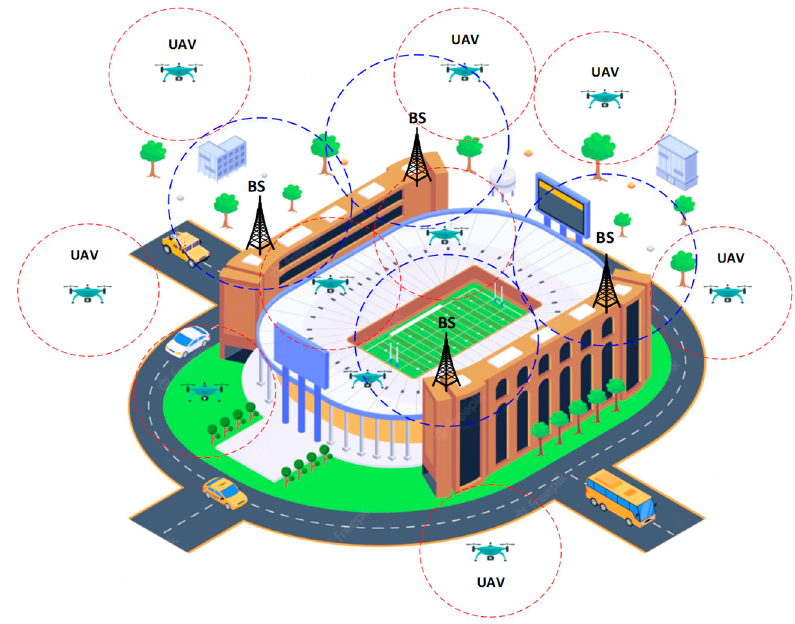
Figure 1. UAVs’ Architecture.